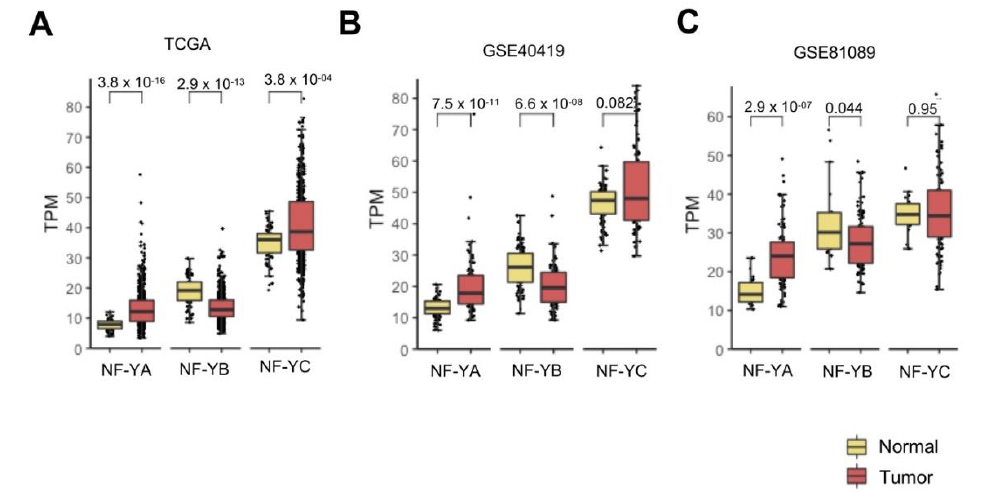
Figure 1. NF-YA was overexpressed in lung adenocarcinoma (LUAD). ( A ) Box plots of expression levels of the three NF-Y subunits at gene level in the TCGA LUAD cohort, measured in TPMs (Transcripts per Millions). ( B ) Same as ( A ), except that the GSE40419 dataset was analyzed. ( C ) Same as ( A ), except that 91 LUAD tumors were analyzed from the previously classified non-small cell lung carcinoma (NSCLC) GSE81089 dataset. p -values were calculated using a Wilcoxon signed-rank test.